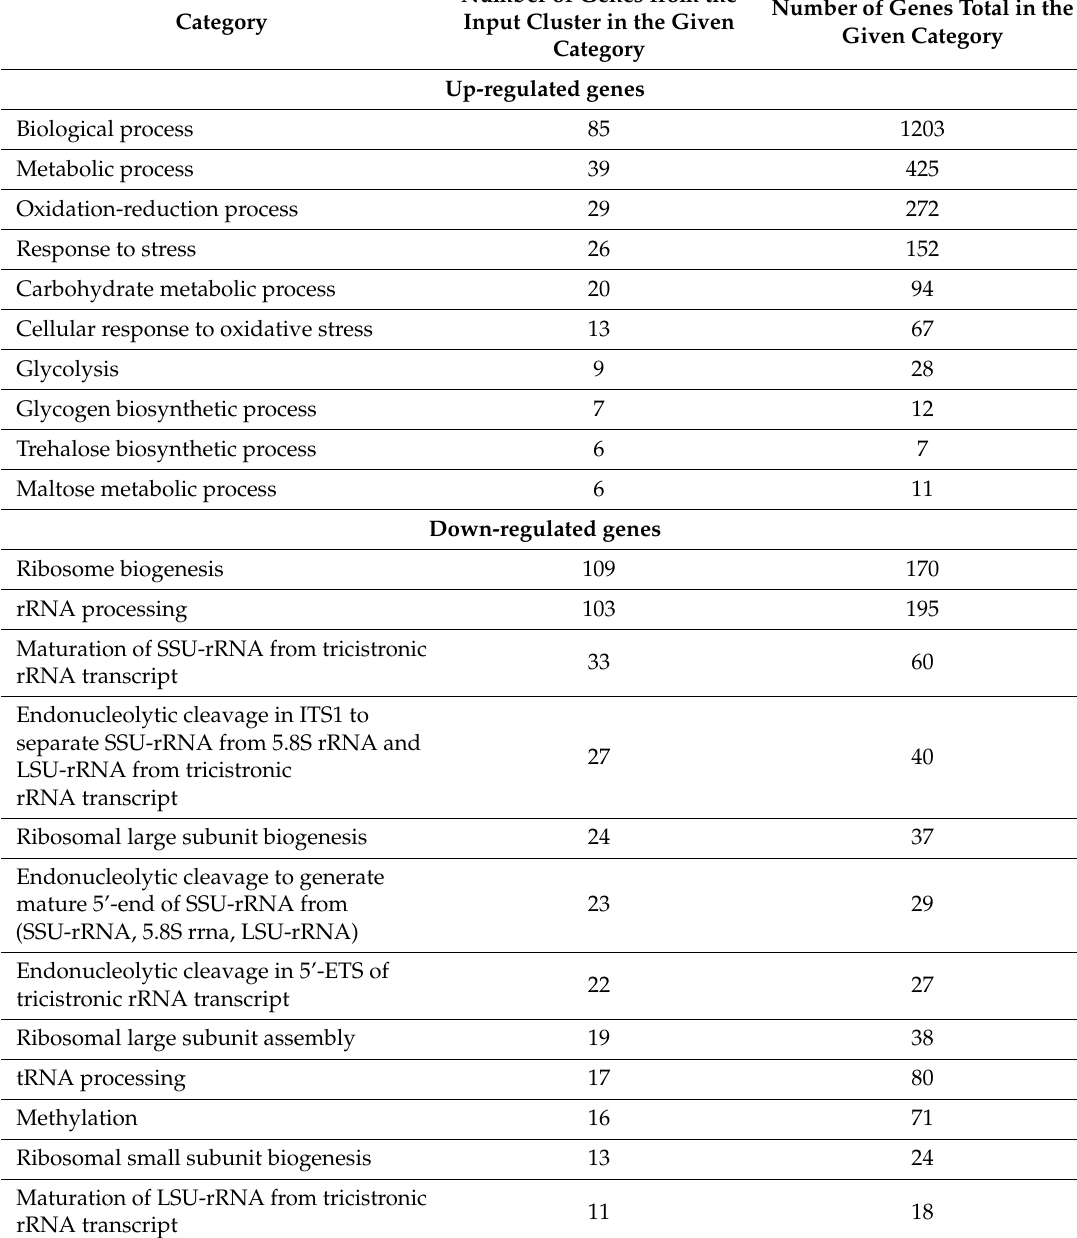
Table 3. Gene ontology analysis results of the upregulated and down-regulated genes in M8FE , in the absence of iron stress, according to their biological process, taken out of 2062 categories. For this analysis, Bonferroni correction [45] was performed and the p -value cut-o ff was selected as 0.01 (LSU: large subunit, SSU: small